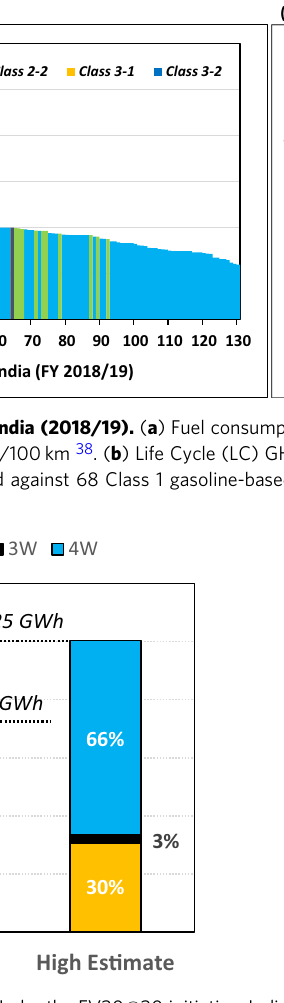
Fig. 7 Demand for batteries by 2030. Under the EV30@30 initiative, India would require between 91 and 125 GWh of batteries to electrify its two- wheelers (2 W), three-wheelers (3 W), and four-wheelers (4 W). High estimate and low estimate are based on the variations in battery sizes deployed in 2 W (2kWh & 3 kWh), 3 W (4.7kWh & 6.6 kWh) and 4 W (30 kWh & 40kWh) 43,103 . The percentages refer to the share of battery requirements for 2 W, 3 W, and 4 W. Breakdown of sales forecast by 2030 is provided in Supplementary Figure 7 of the supporting document based on data from Council on Energy, Environment, and Water (CEEW) India 43